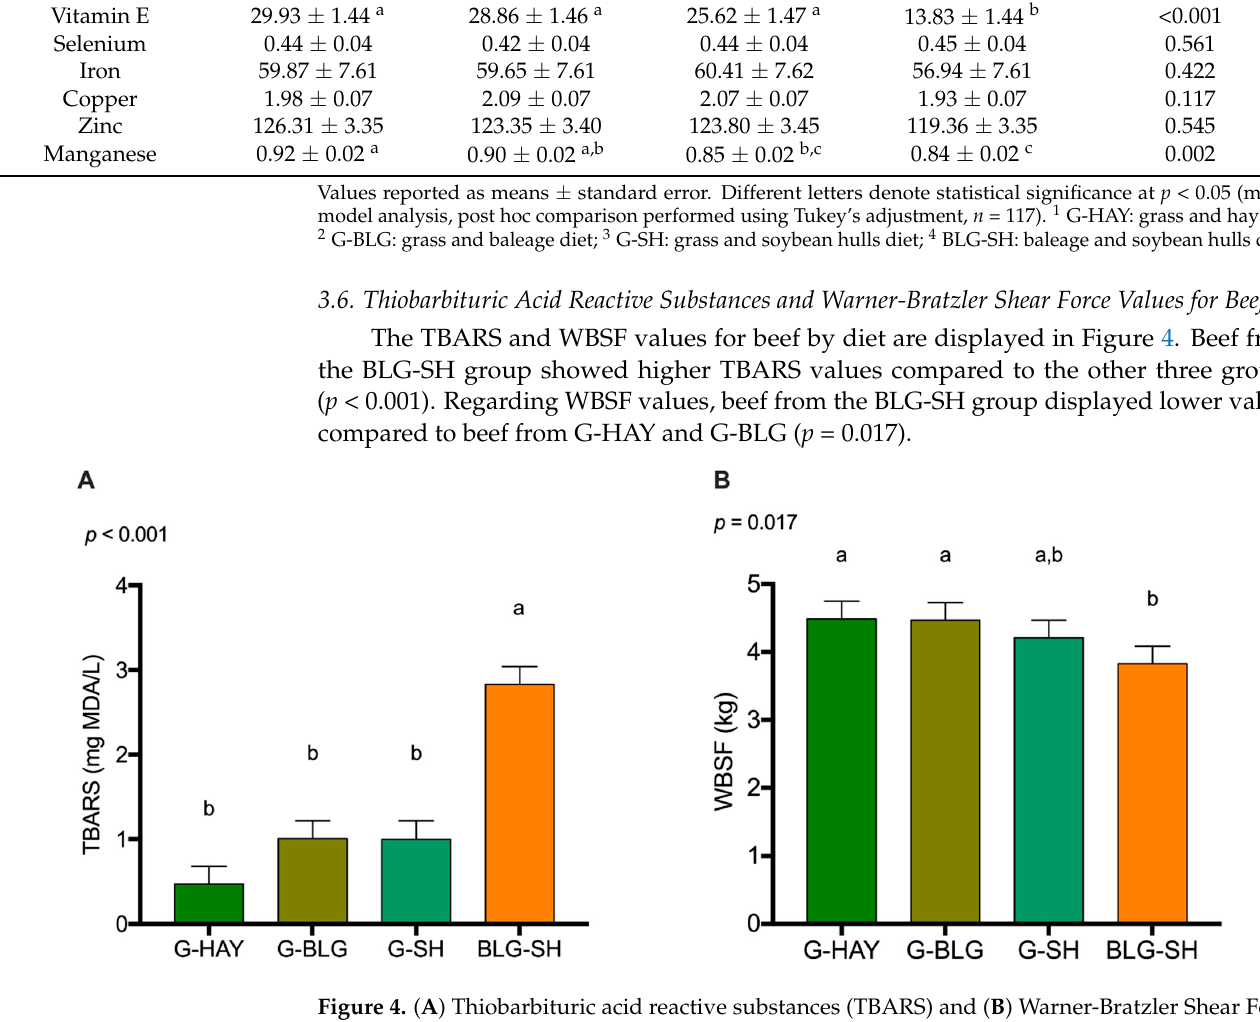
Figure 4. ( A ) Thiobarbituric acid reactive substances (TBARS) and ( B ) Warner-Bratzler Shear Force (WBSF) values of beef by diet. Data shown as means ± standard error. Different letters denote sta- tistical significance at p < 0.05 (mixed model analysis, post hoc comparison performed using